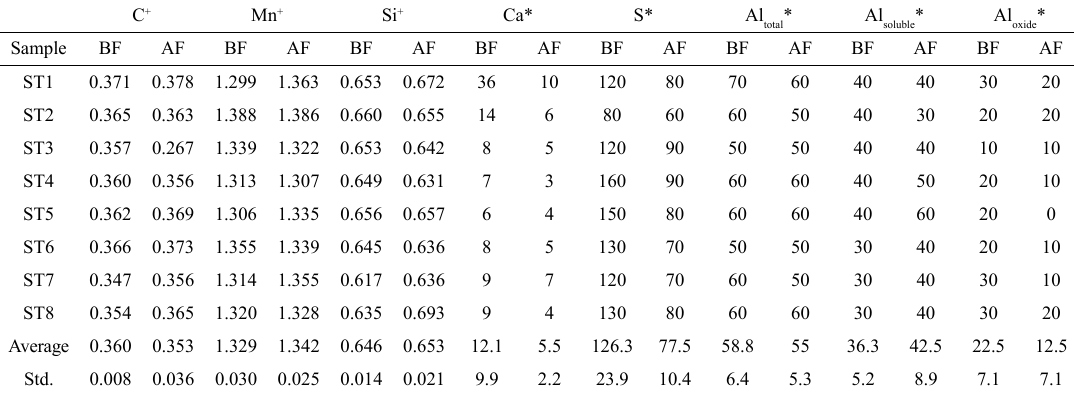
Std. Table 2. Steel composition before (BF) and after (AF) vacuum treatment. C + Mn + Si + Ca* S* Al Sample BF AF BF AF ST2